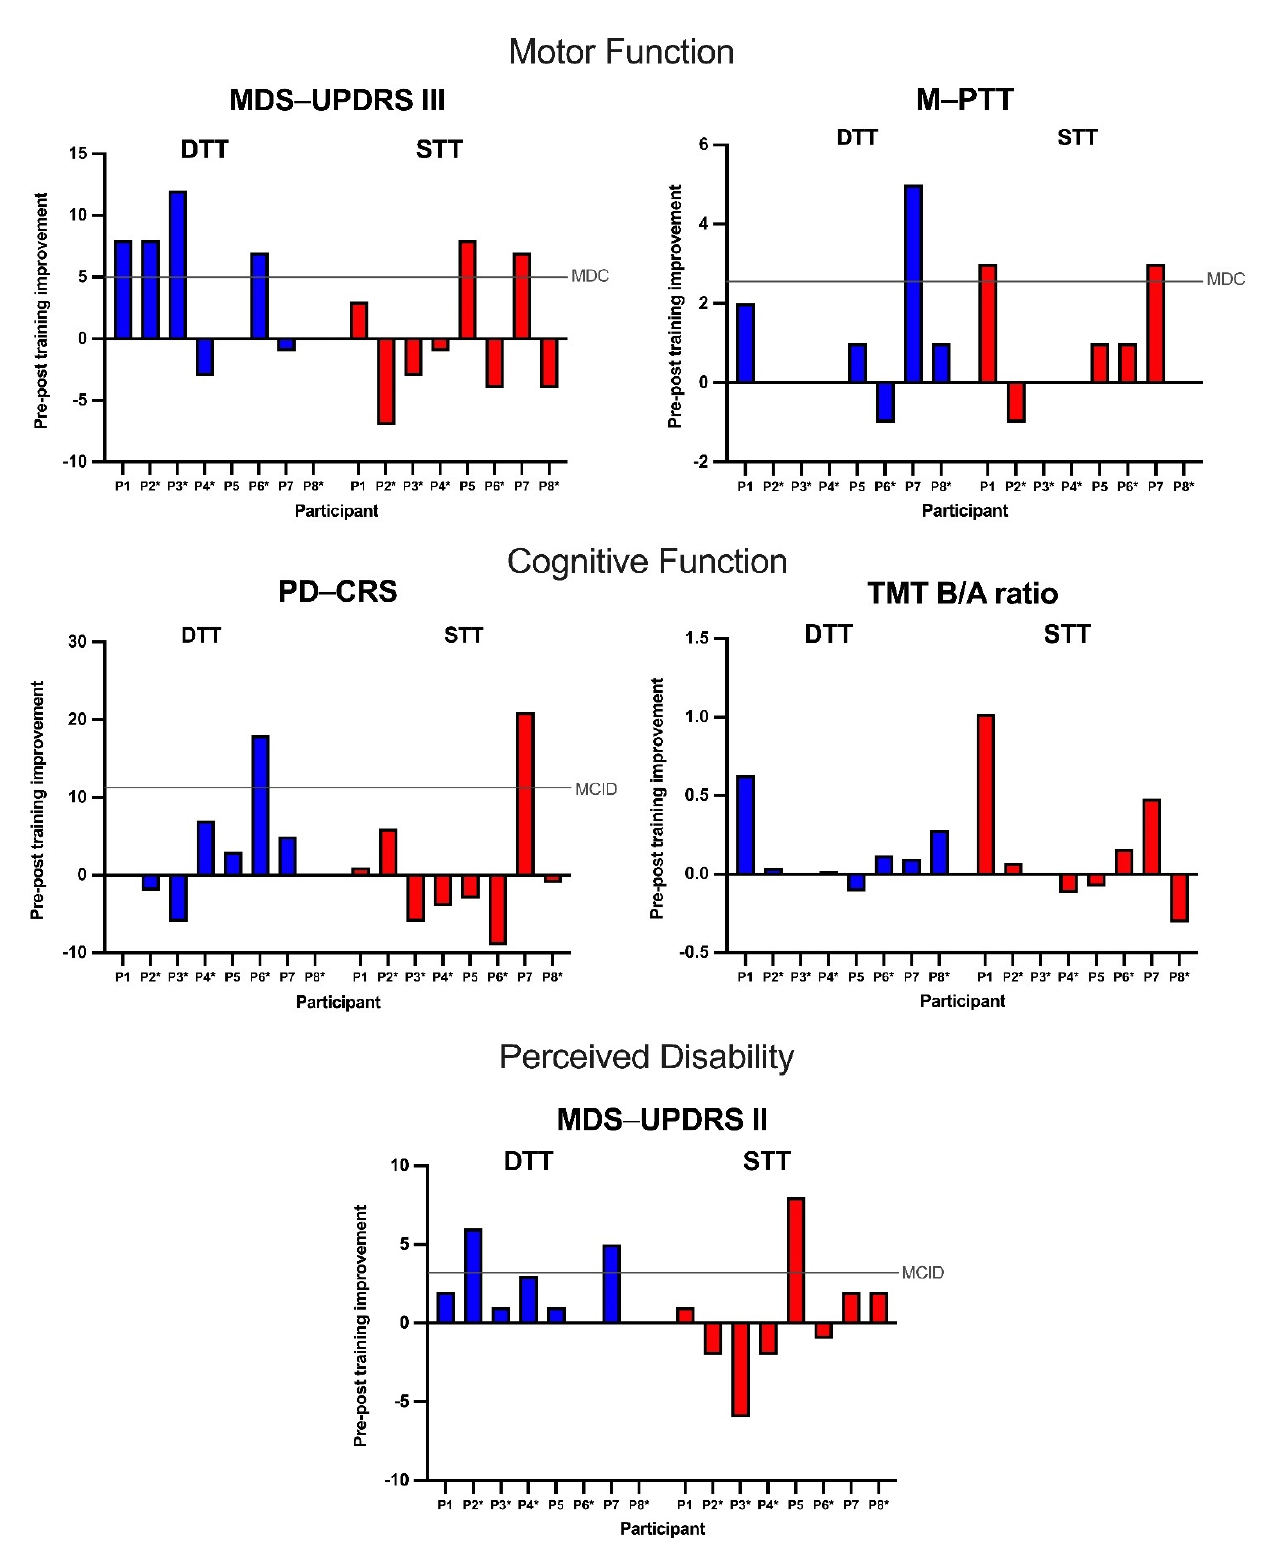
Figure 1. Comparison of individual raw change scores between DTT and STT for five outcome measures. Reference lines indicate values of minimal detectable change (MDC) or minimum clinically important difference (MCID); no MDC and MCID values of TMT B/A ratio have been established for adults with PD. * Participant was assigned the dual-task training condition followed by the single-task training condition.